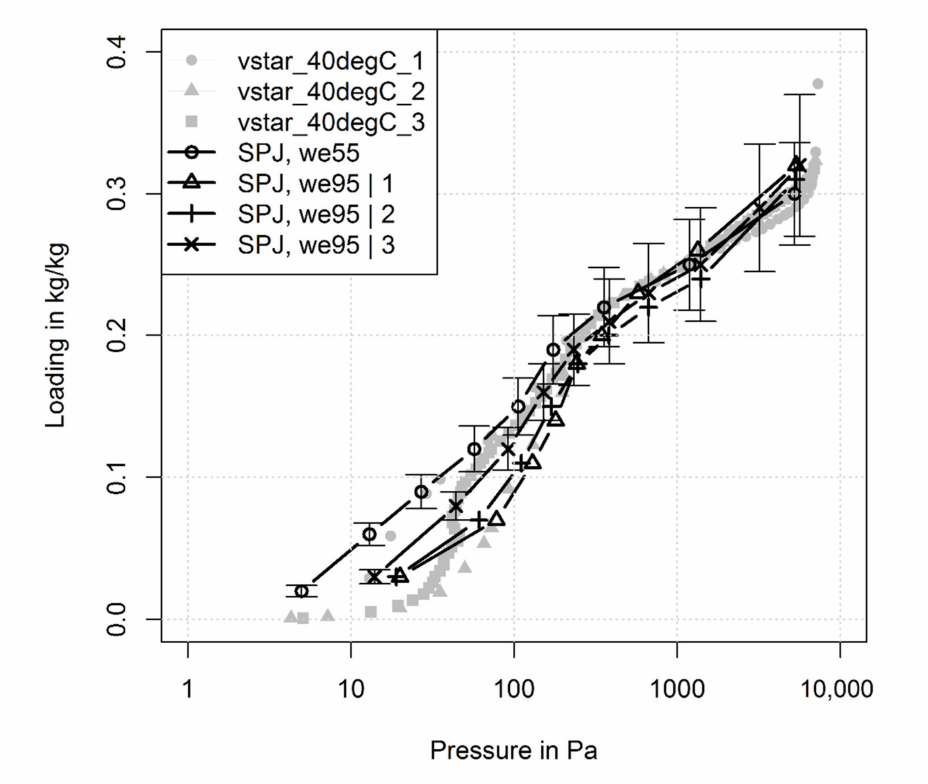
Figure 5. Equilibrium data for the 40 ◦ C isotherm of powder material (“vstar” measurements) and the samples we55 and we95 (“SPJ” measurements). Lines are meant as a guide to the